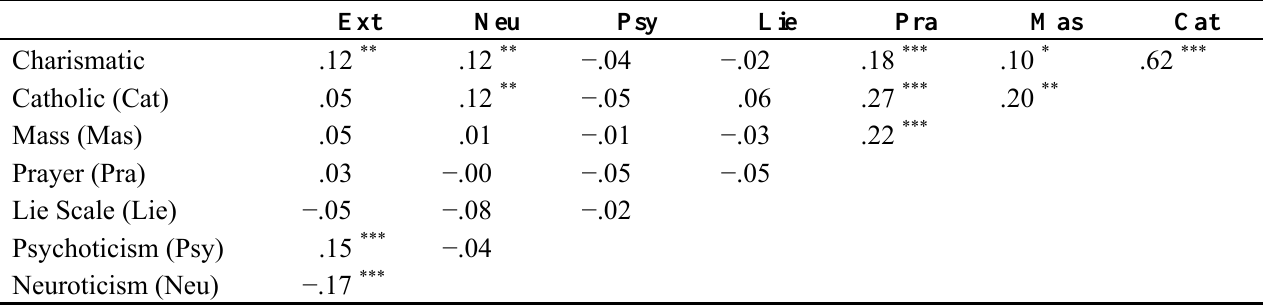
Table 4. Partial correlation matrix, controlling for sex and